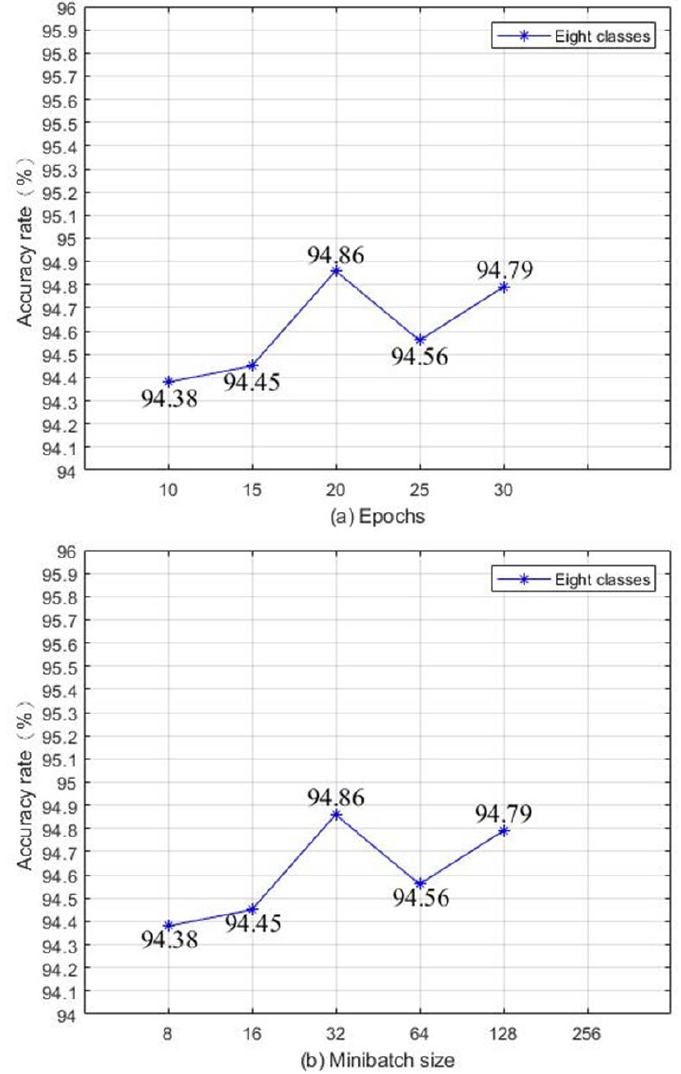
Figure 13. Illustration of the accuracy of eight tissue classes (Kather-texture-2016-image-5000) using ( a ) epoch and ( b ) mini-batch size.